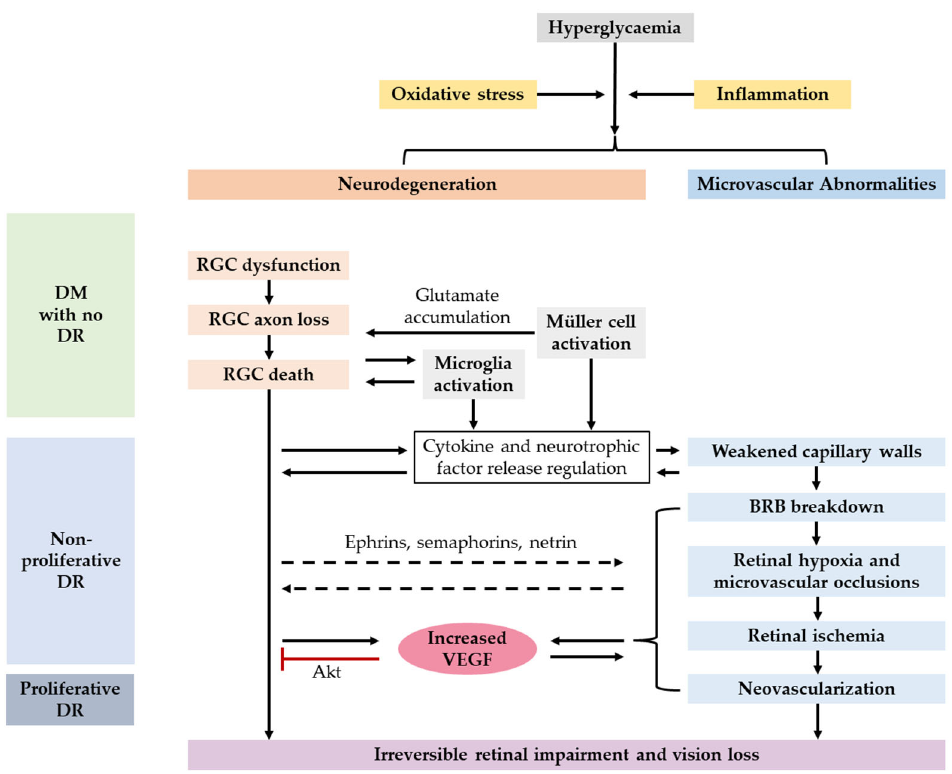
Figure 1. General phases of diabetic retinal neurodegeneration and microvascular abnormalities, and the controversial role of VEGF. DM, diabetes mellitus; DR, diabetic retinopathy; RGC, retinal ganglion cell; VEGF, vascular endothelial growth factor; BRB, blood ‐ retinal barrier.